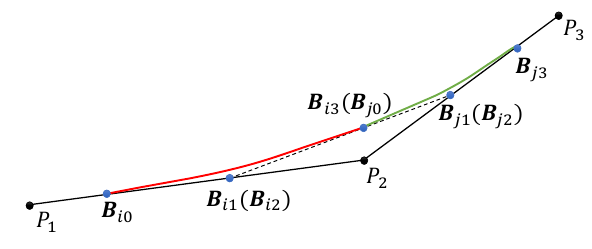
Figure 9. Curve for smoothing.